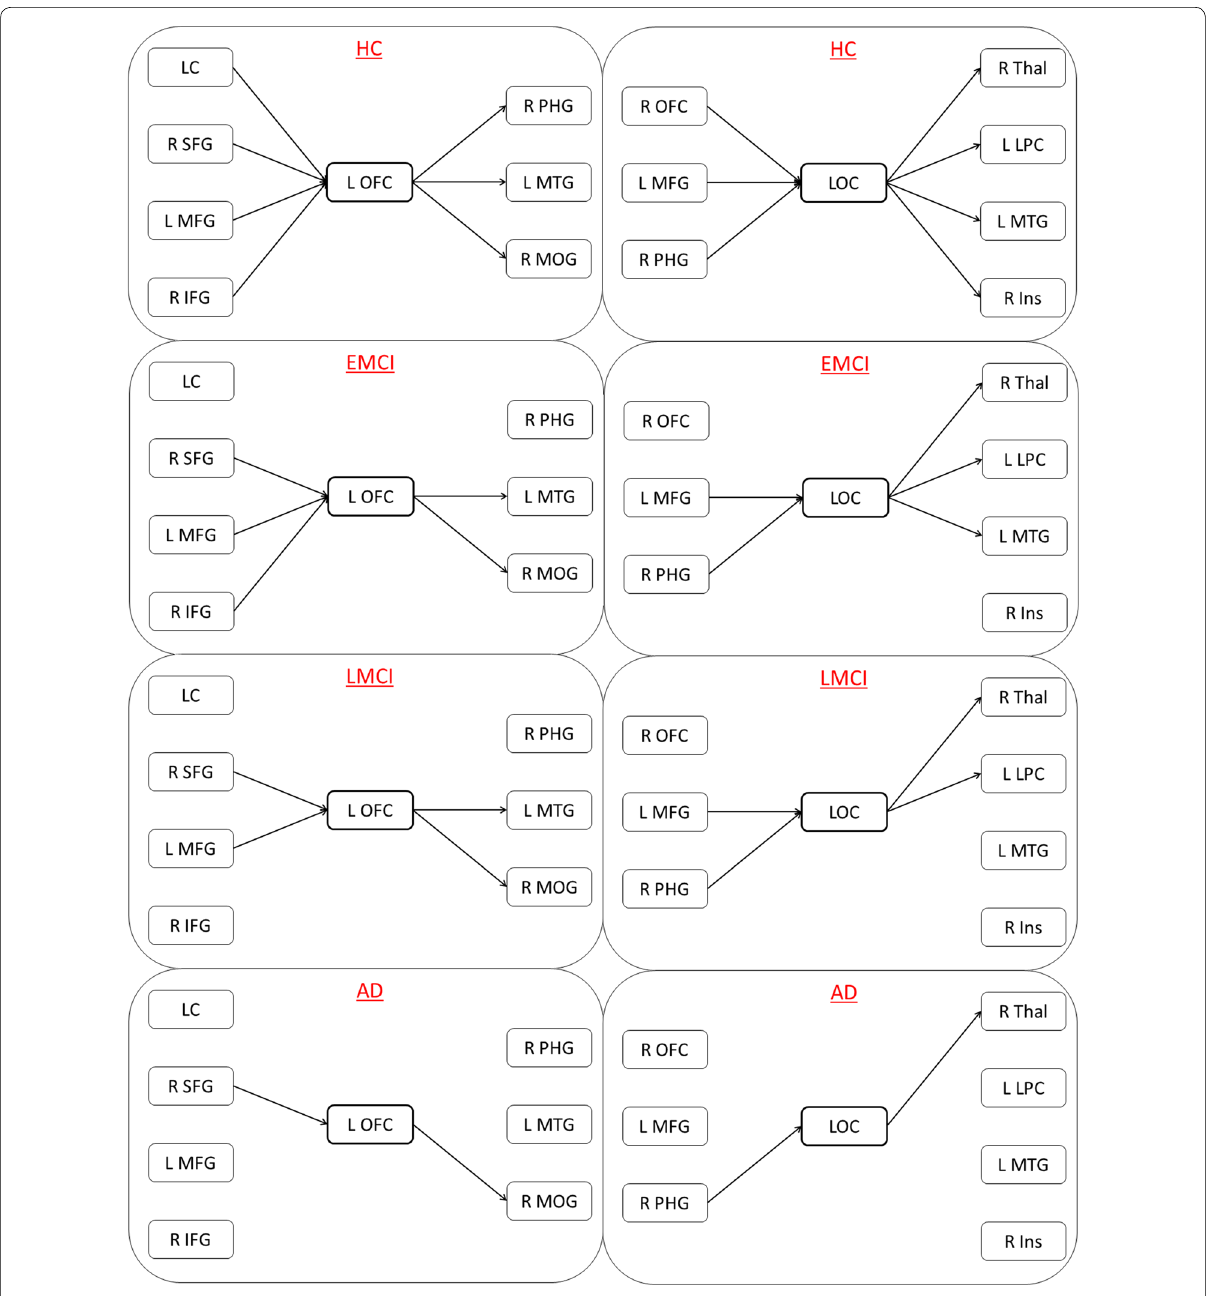
Fig. 6 Middleman nodes L OFC (left) and LOC (right) with corresponding incoming and outgoing connections. From top to bottom: HC, EMCI, LMCI, AD. We can observe gradual pruning of the connections associated with these middleman nodes as the disease progresses from EMCI through AD. OFC orbito-frontal cortex, LOC lateral occipital cortex, LC locus coeruleus, SFG superior frontal gyrus, MFG middle frontal gyrus, IFG inferior frontal gyrus, PHG parahippocampal gyrus, MTG middle temporal gyrus, MOG middle occipital gyrus, Thal thalamus, LPS lateral parietal cortex, Ins